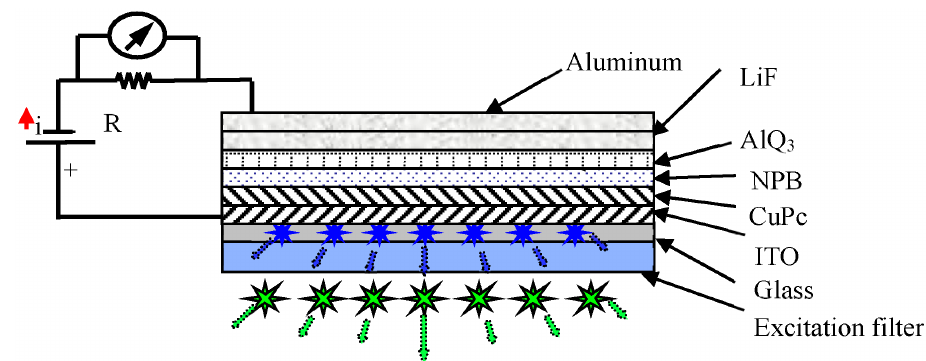
Figure 3. Design layout of organic light emitting diode (OLED) chip.